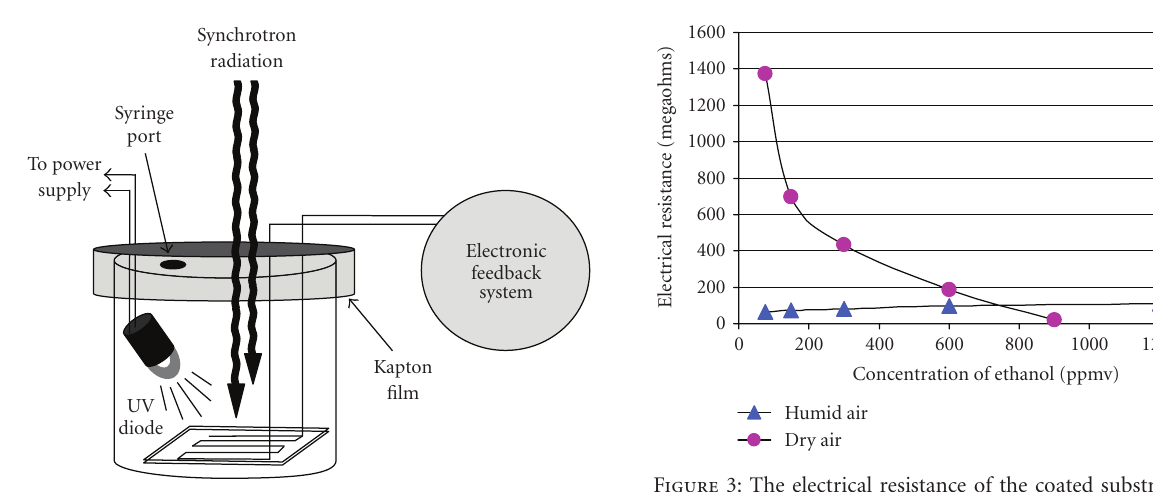
Figure 3: The electrical resistance of the coated substrates in dry air and in humid air in darkness as the ethanol concentration in the Figure 2: Test setup in XRF cups. atmosphere above the substrates progressively